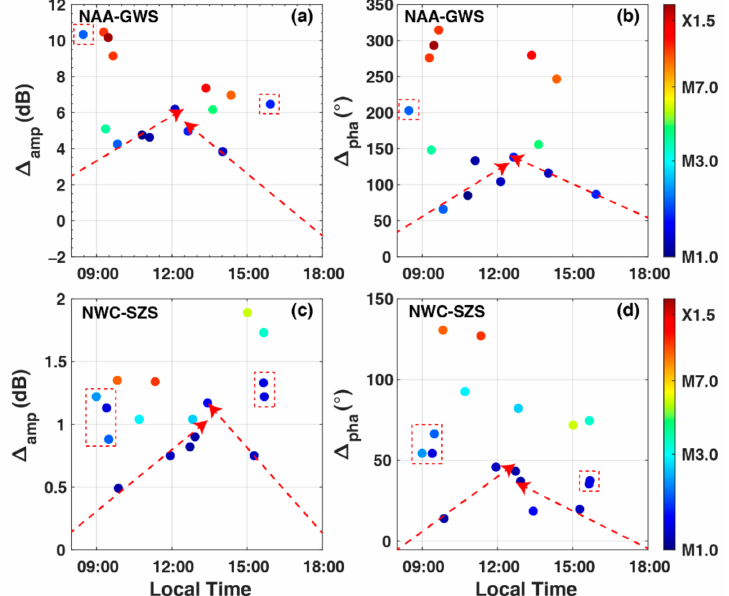
Figure 5. The VLF signal amplitude and phase perturbations to the solar flares as a function of local time for NWC and NAA transmitter signals,